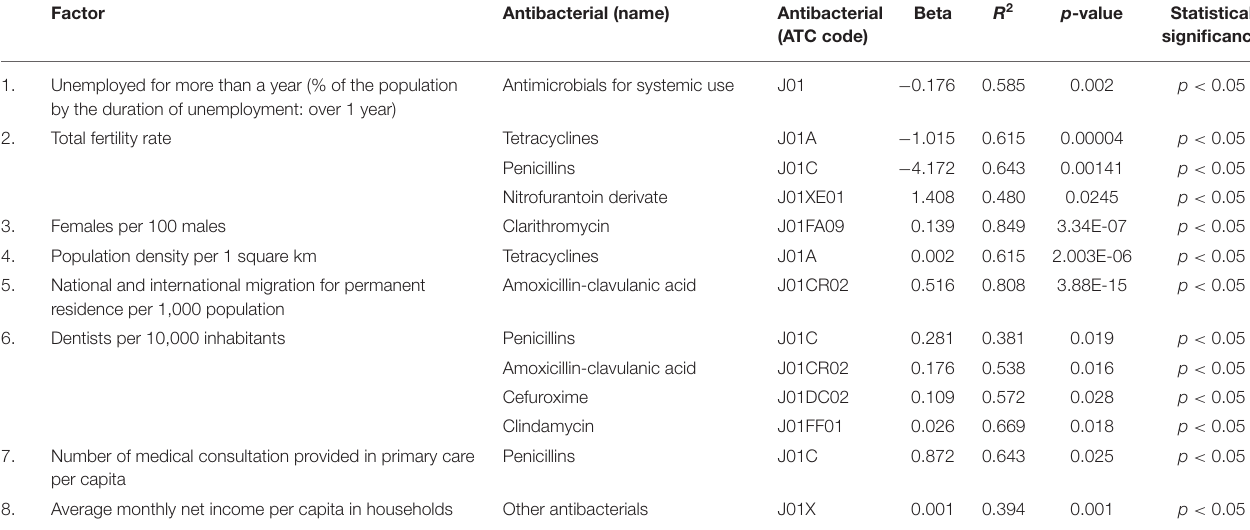
TABLE 1 | Antimicrobials used in the period 2013–2017 in primary care in Poland by ATC names [substances of consumption over 0.1 defined daily doses (DDD) per 1,000 inhabitants per day (DID) are listed]. Subgroups ATC code